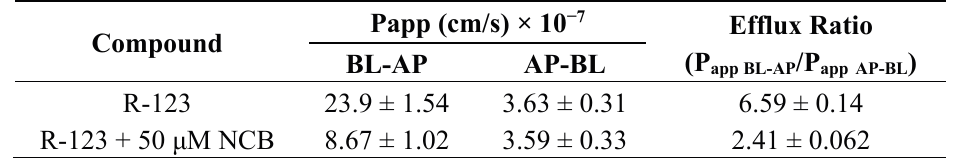
Table 1. Effects of NCB on the transport of R-123 across MDCK-hMDR1 cell monolayers.